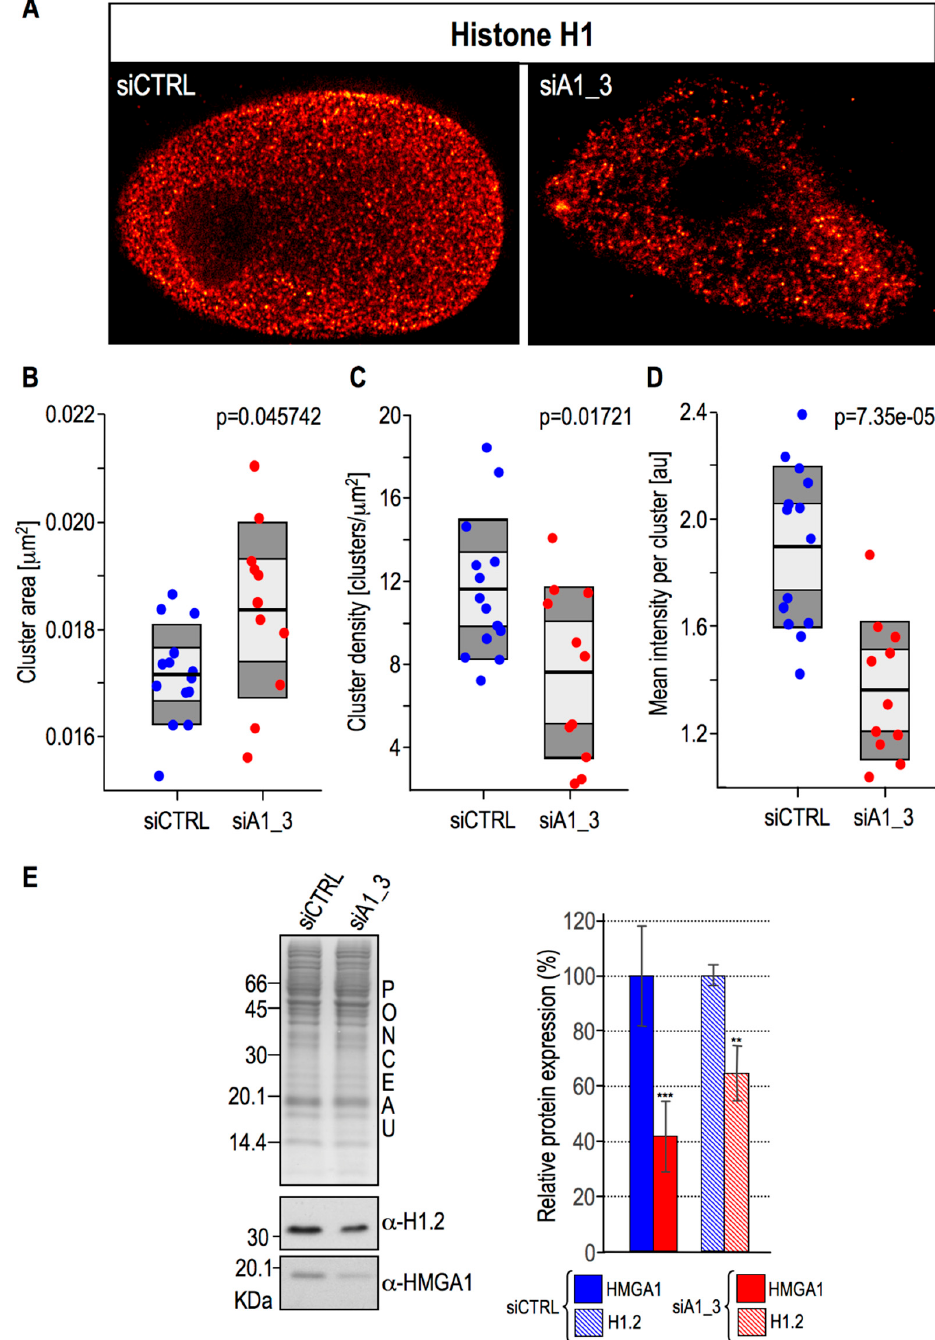
Figure 5. HMGA1 influences histone H1 nuclear distribution and protein expression. ( A ) Representative STED microscopy images of MDA-MB-231 cells silenced for HMGA1 (siA1_3) or treated with control siRNA (siCTRL) and immunostained for histone H1. ( B – D ) Box plots showing the median area, density, and mean intensity of histone H1 clusters. (siA1_3: n = 11; siCTRL: n = 14). ( E ) Western blot analyses to assess HMGA1 and histone H1.2 protein expression levels in MDA-MB-231 cells silenced for HMGA1 (siA1_3) or treated with control siRNA (siCTRL). Representative WB analyses are shown together with red ponceau stained membranes to verify total protein normalization. The histogram graphs relative to Western blot analyses were obtained using densitometric analyses (siCTRL versus siA1_3). Bars indicate the means. Standard deviations are shown ( n = 3). Statistical significance was assessed with Student’s t test (*: p ≤ 0.05; **: p ≤ 0.01; ***: p ≤ 0.001). Molecular weight markers are indicated on the left